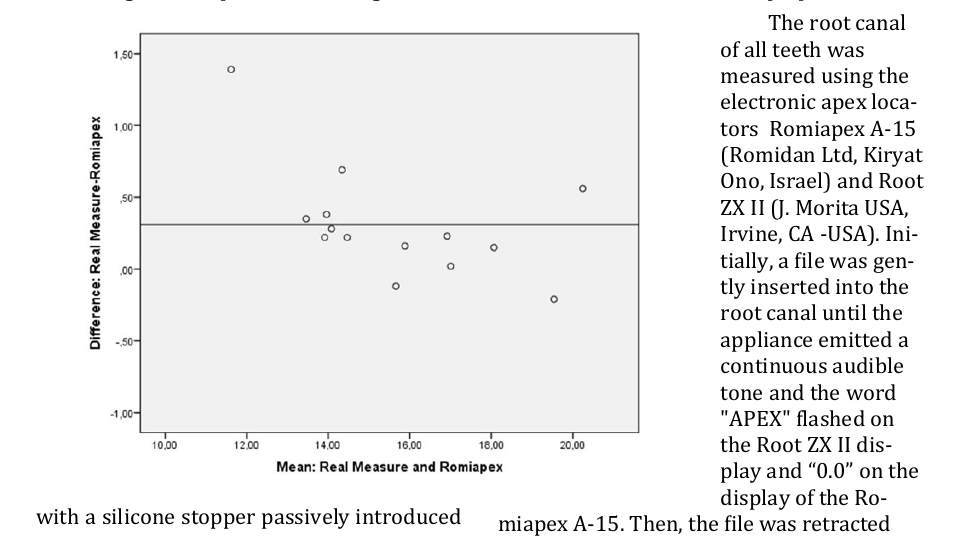
Figure 2. Graphical representation of the difference in values ob- tained using the electronic apex locator Romiapex A-15 and the real